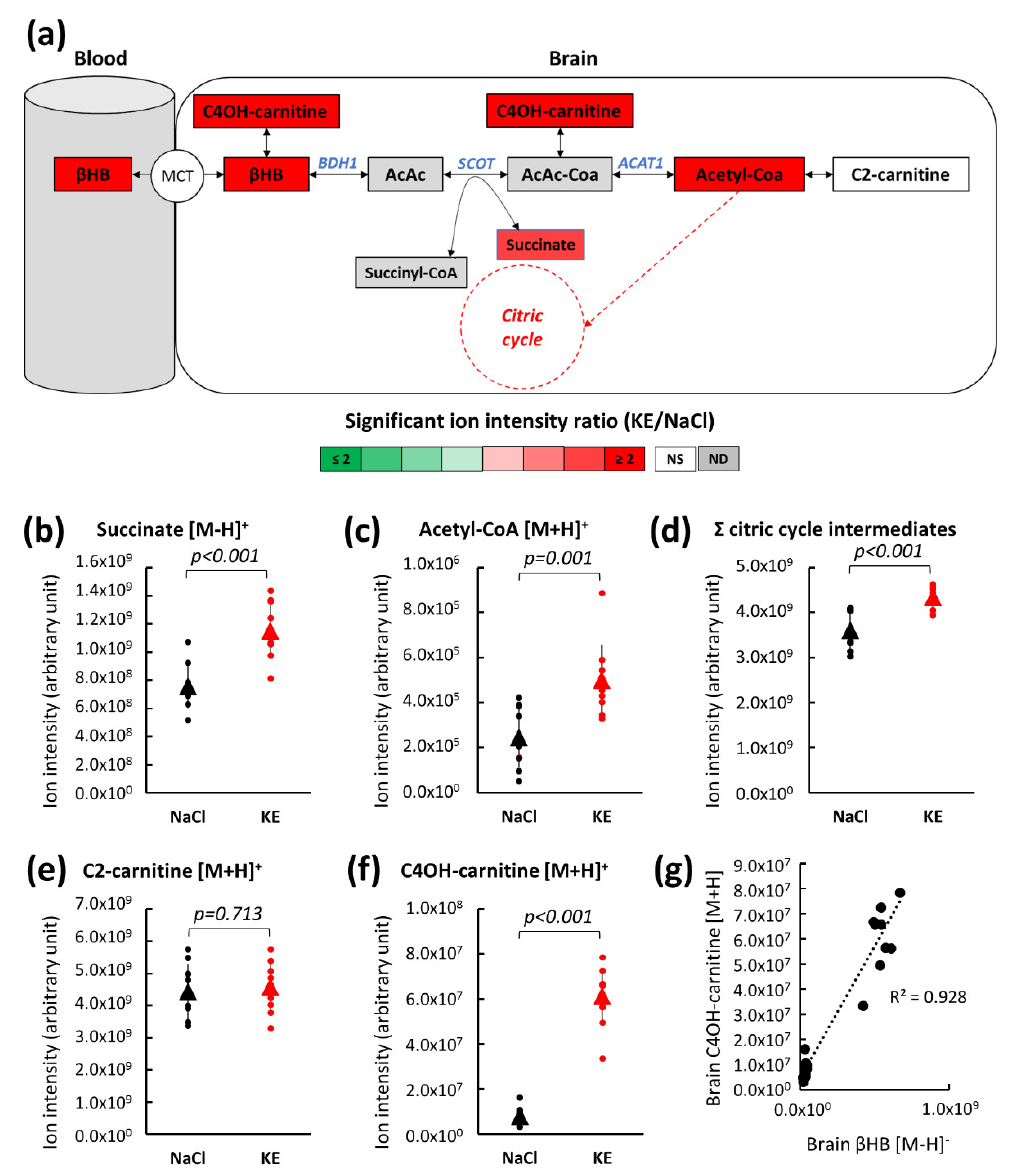
Figure 5. Brain metabolite levels of the β HB pathway after KE ingestion. Schematic representation of the brain β HB pathway indicating significant metabolic changes for the relevant intermediates by color code. Brain metabolite levels were assessed by LC-MS 30 min after the ingestion of KE (3 mg KE/g of body weight) or 0.9% NaCl ( a ). Individual LC-MS analysis of succinate ( b ), acetyl-CoA ( c ), total citric acid cycle intermediates ( d ), C2-carnitine ( e ), and C4OH-carnitine ( f ). Correlation between β HB and C4OH-carnitine in brain 30 min after the ingestion of KE (n = 10) ( g ). (ND: not detected; NS: